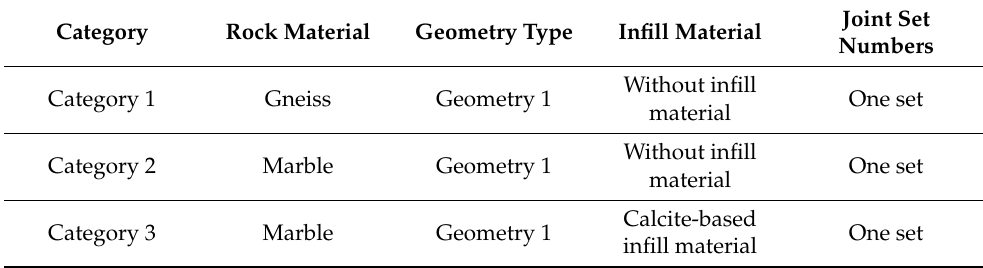
Table 2. The list of examined parameters’ values.